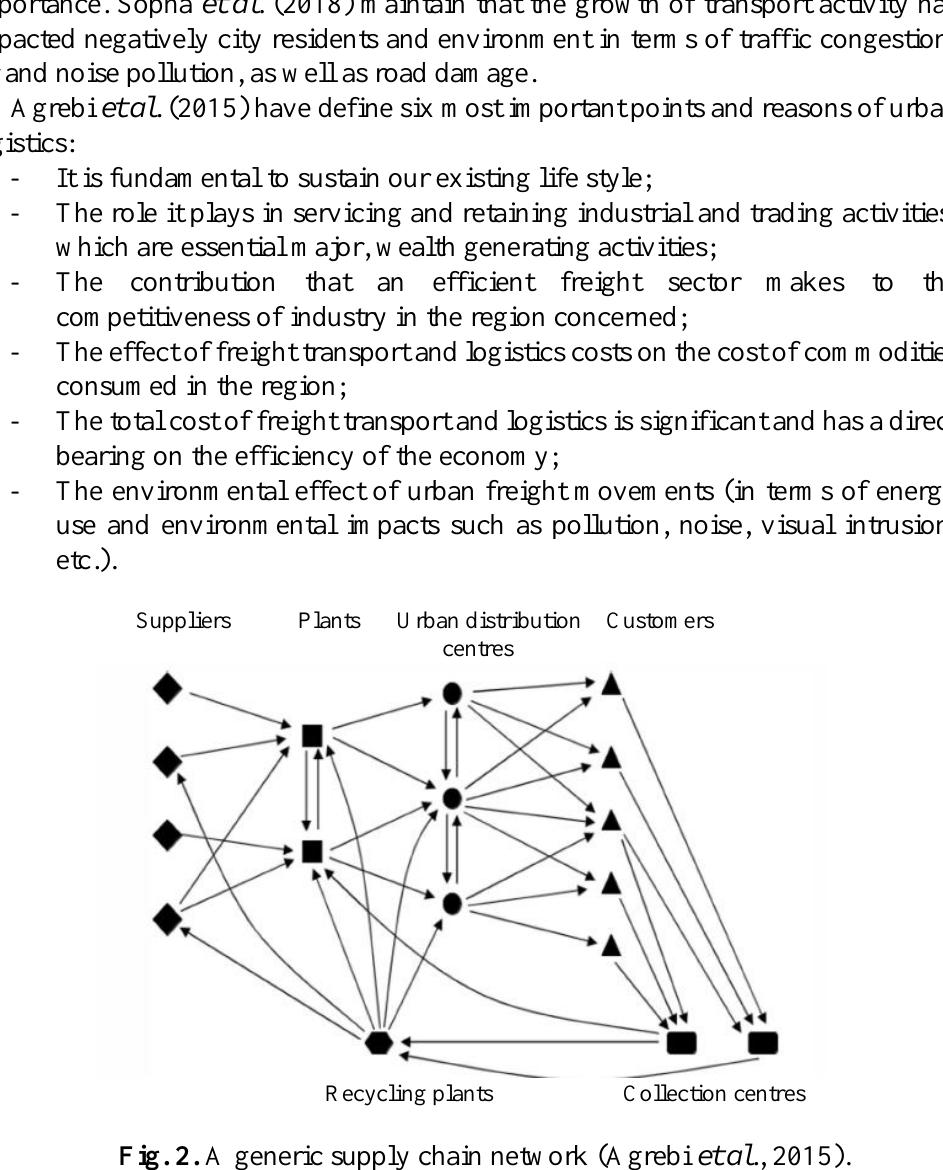
Fig. 2. A generic supply chain network (Agrebi et al .,